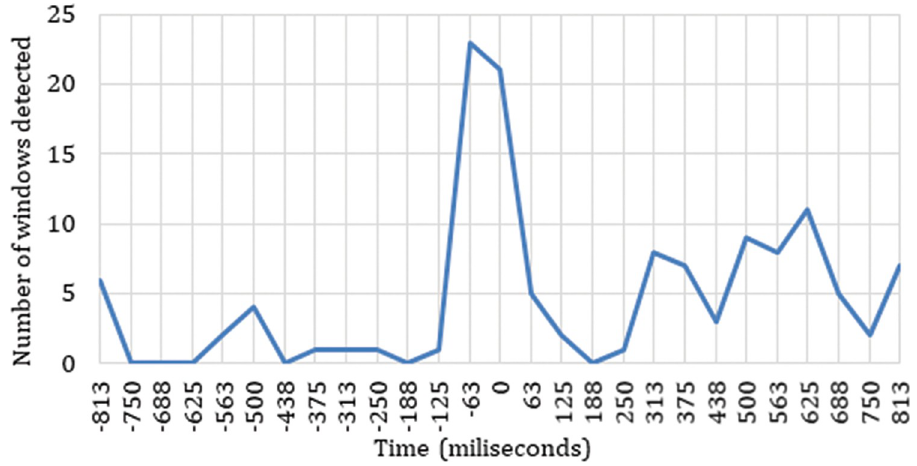
Fig 2. Distribution of the sliding windows detected as neuronal responses triggered by the cut